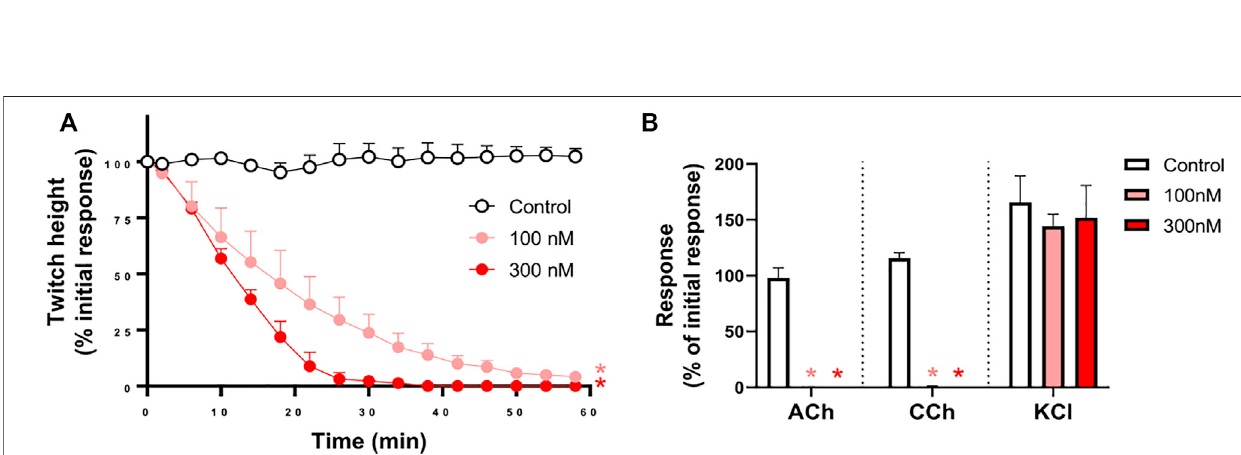
Frontiers in Pharmacology |